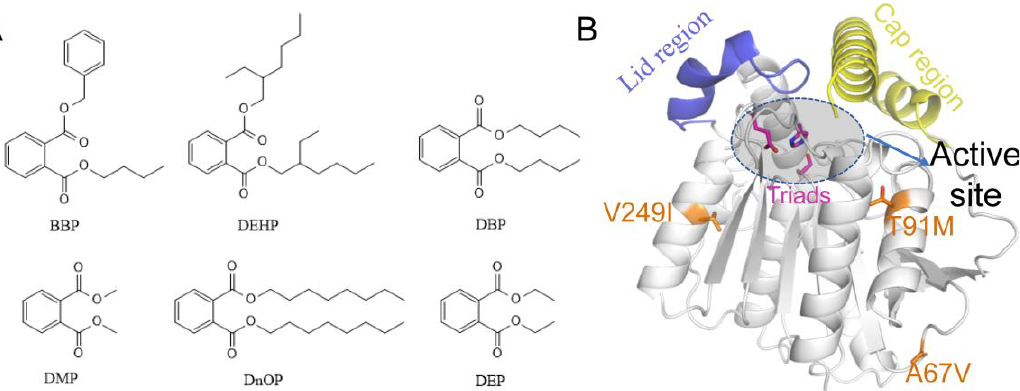
Figure 1. The 2D structures of six common PAEs and the 3D structure of EstJ6. ( A ) The 2D structures of six common PAEs including BBP, DEHP, DBP, DMP, DnOP, and DEP. ( B ) Overview of EstJ6 stereo structure and mutation sites for ET2.2. Magenta sticks represent triads S146, E240, and H270. Essential motifs including lid and cap regions are colored purple and yellow, respectively. The substrate binding pocket is highlighted by an oval.